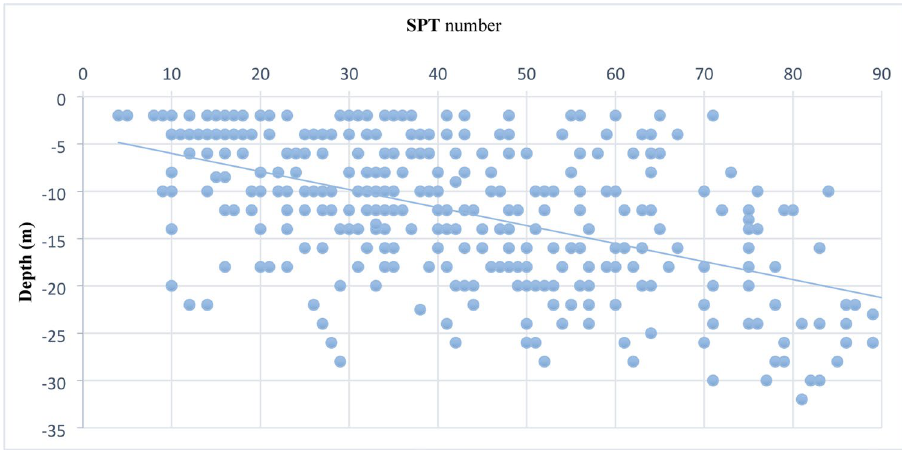
Fig. 9 The trend lines SPT-N/ depth in the route of TML2